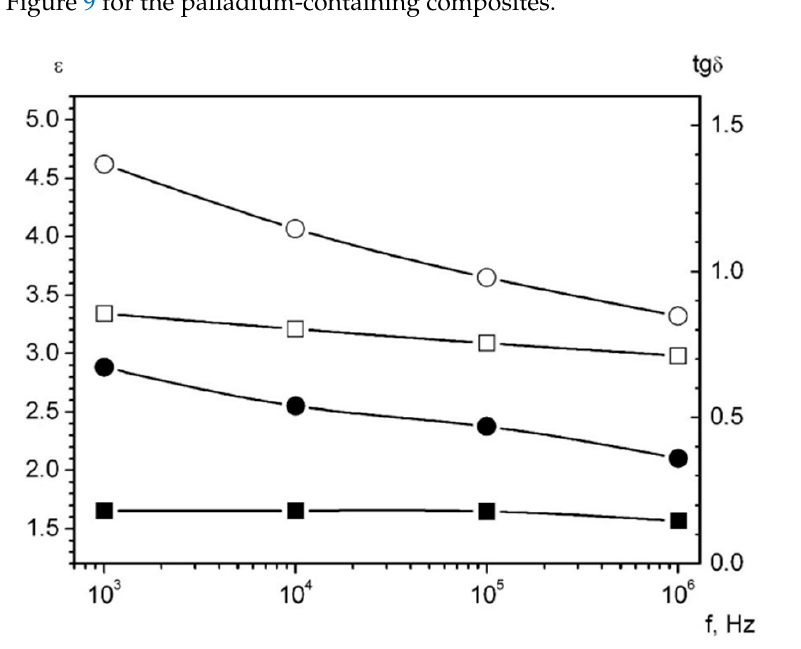
Figure 9. The dielectric permeability and the loss tangent for the composites. Black symbols represent tg δ . The white symbols show ε . The squares are for the sample Pd 10 wt%, the circles are for the sample Pd 20 wt%.